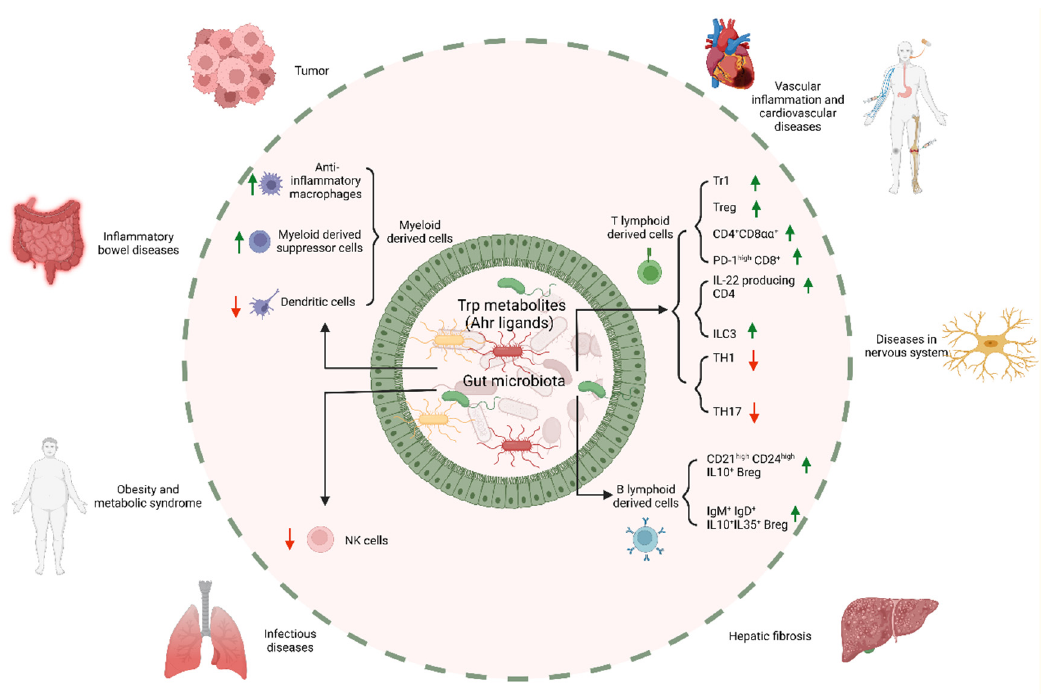
Figure 2. Effects of Trp metabolites derived from the gut microbiota on the immune cells and immune-associated diseases. Trp metabolites promote the differentiation and/or function of immunosuppressive cells such as anti-inflammatory macrophages, myeloid-derived suppressor cells, Tr1, Treg, CD4 + CD8 αα + , PD-1 high CD8 + , ILC3, IL-22-producing CD4, CD21 high CD24 high IL-10 + Breg and IgM + IgD + IL-10 + IL35 + Breg, whereas the differentiation and/or function of some immune cells such as dendritic cells, TH1, TH17 and NK cells are inhibited. Trp metabolites derived from the gut micro- biota can affect the occurrence and development of some diseases through regulating immune cells, such as inflammatory bowel diseases, vascular inflammation and cardiovascular diseases, hepatic fibrosis, diseases in the nervous system, obesity and metabolic syndrome, tumors and infectious diseases.